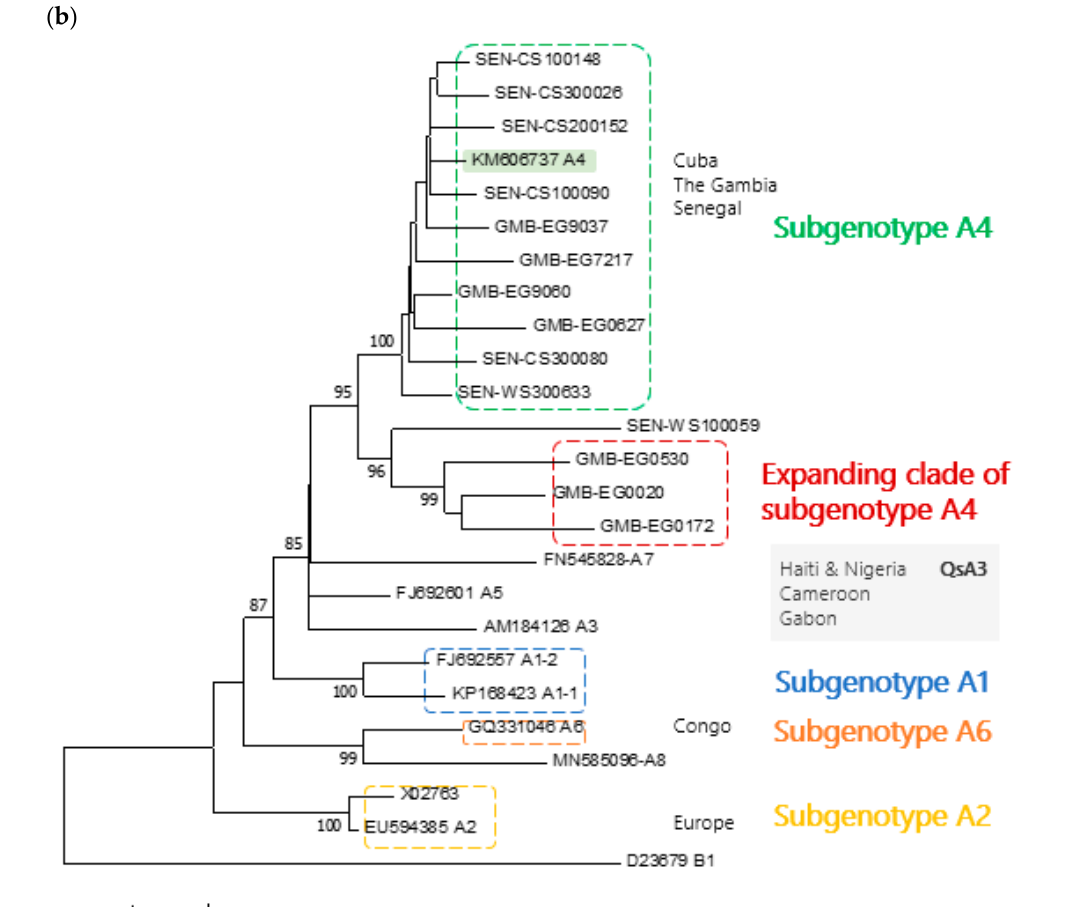
Figure 1. Genomic length maximum likelihood phylogenetic tree constructed based on Hepatitis B virus (HBV) sequences isolated in patients from The Gambia and Senegal and ( a ) genotype A–J reference sequences and ( b ) genotype/subgenotype A reference sequences retrieved from the GenBank database and rooted on an HBV genotype B sequence. Samples sequenced in this study are identified by the prefixes GMB (The Gambia) and SEN (Senegal). The numbers at each node correspond to the bootstrap values (greater than 70%) obtained with 1000 replicates.